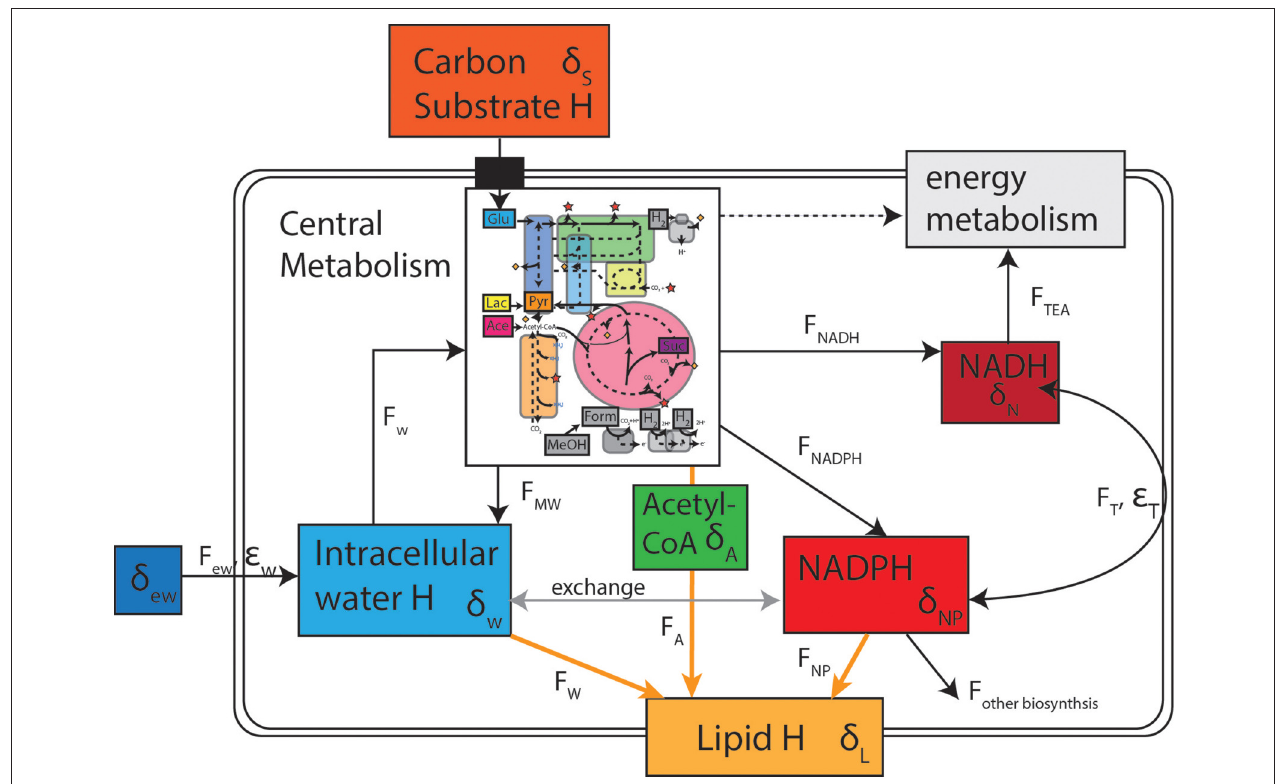
FIGURE 4 | Conceptual model of the reservoirs of hydrogen as well as fluxes and fractionations that contribute to the ultimate isotopic composition of lipids. Inset of central metabolism is after that of Sauer et al. (2003) and Zhang et al.